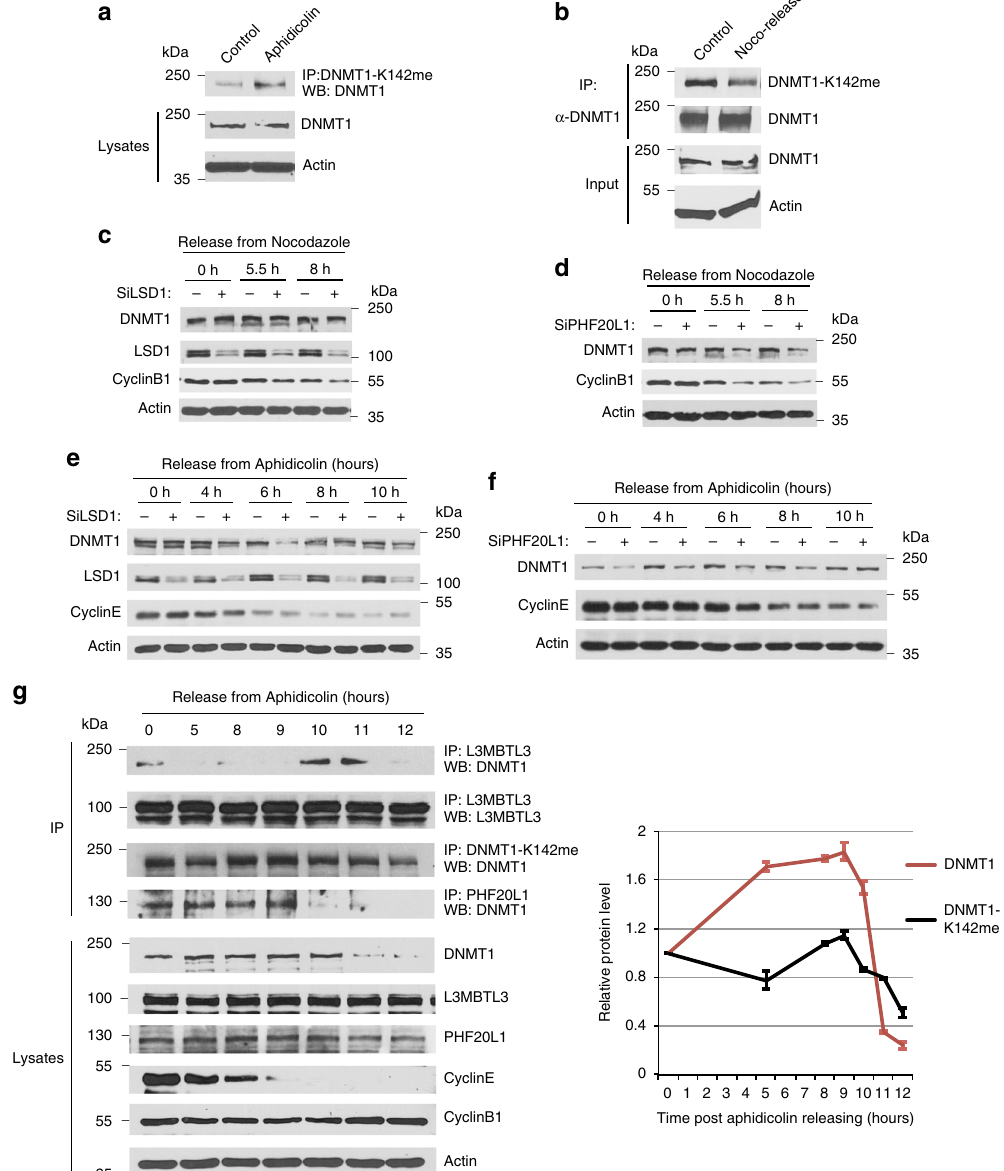
Fig. 8 The methylation-dependent proteolysis of DNMT1 is cell cycle regulated. a S phase cells contain higher levels of methylated DNMT1. HCT116 cells were treated with DMSO or 5 μ g/ml aphidicolin for 18 h. Methylated DNMT1 was immunoprecipitated with anti-monomethylated K142 antibodies and blotted with anti-DNMT1 antibodies. b G1 cells are low in methylated DNMT1. HCT116 cells were treated with DMSO or 40 ng/ml nocodazole for 14 h. The mitotic round-up cells were collected, washed, and re-plated in fresh medium. The G1 cells were lysed at 7.5 h after re-plating. DNMT1 proteins were immunoprecipitated by anti-DNMT1 antibodies and blotted by anti-monomethylated K142 and anti-DNMT1 antibodies. c HCT116 cells were transfected with luciferase and LSD1 siRNAs for 30 h, treated with nocodazole for 14 h, and mitotic rounded-up cells were collected and released into fresh medium, as in b . The late mitotic, early and mid G1 cells were collected at 0, 5.5, and 8 h. DNMT1, LSD1, cyclin B1 (degraded in G1), and actin were examined by western blotting. d The same as c except that HCT116 cells were treated with PHF20L1 siRNAs for 30 h, followed by mitotic shake-off and release into G1. e HCT116 cells were transfected with luciferase and LSD1 siRNAs for 30 h and synchronized at the G1/S border by sequential treatment of 2.5 mM thymidine and 5 μ g/ml aphidicolin. The released S phase cells were collected at indicated time points. The levels of DNMT1, LSD1, cyclin E (high in G1/S and early S) and actin were analyzed by western blotting. f The same as e except that HCT116 cells were treated with PHF20L1 siRNAs, g HCT116 cells were synchronized at the G1/S border as in e . Cells were collected at various indicated time points after release and the levels of the K142-methylated DNMT1, total DNMT1, and their interactions with L3MBTL3 or PHF20L1 were analyzed by immunoprecipitation and western blotting. Quanti fi cations were represented by bar graph with mean and standard deviation (S.D.) for error bars from three replicates and experiments were repeated three independent times with the same